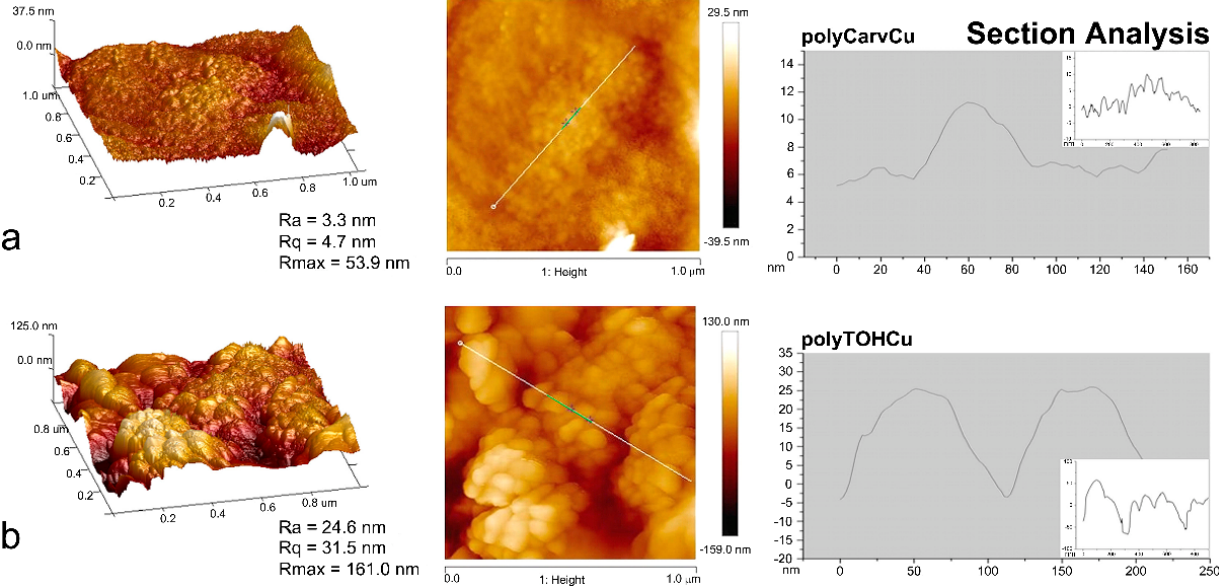
Figure 10. Atomic force microscopy images of polycarvacrol/Cu ( a ) and polythymol/Cu ( b ). Reprinted from [71] with permission from Elsevier.